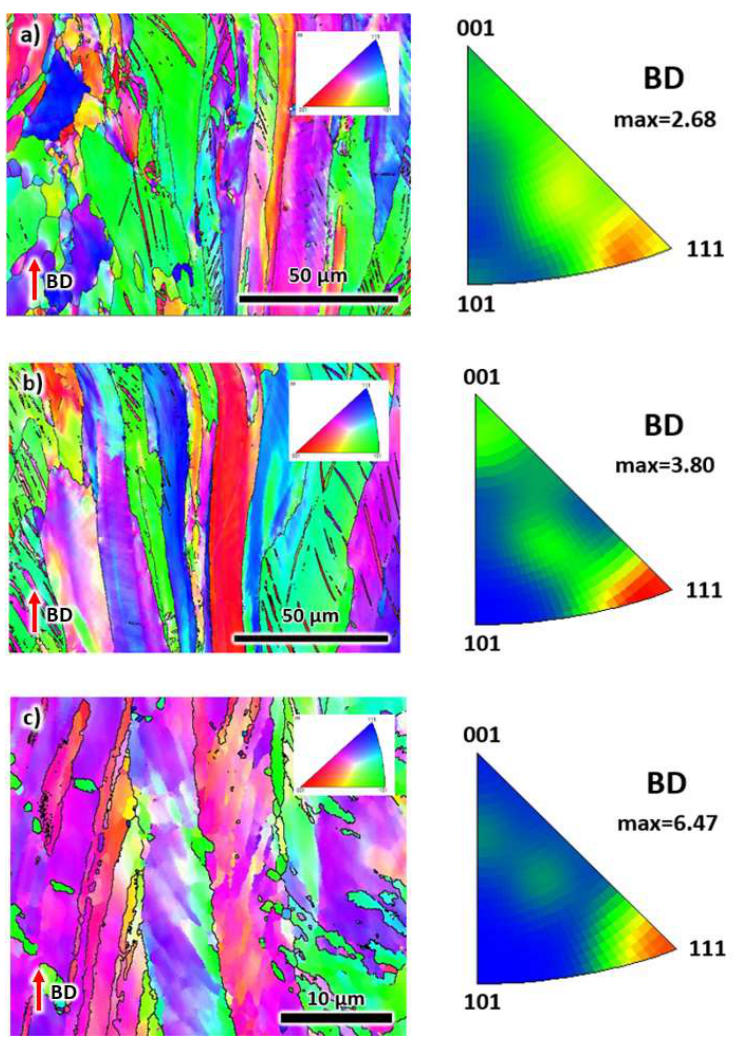
Figure 13. The EBSD IPF-Z map and IPF representation of tensile tested samples: ( a ) as-printed, ( b ) annealing heat treated, and ( c ) hot isostatic pressed and annealing heat treated.